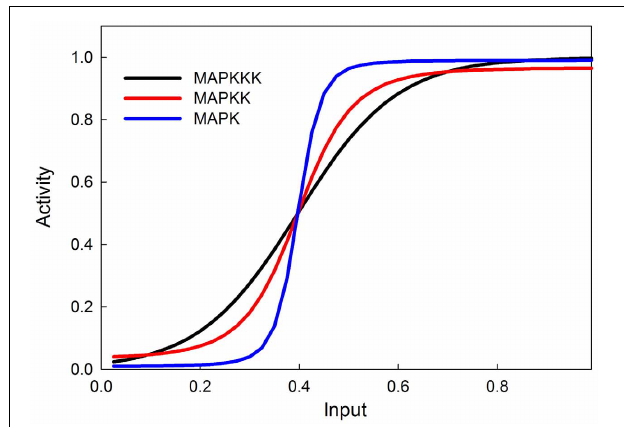
FIGURE 6 | Insulin dose response curves of various components of the insulin and MAPK signaling pathways replicating (Stagsted et al., 1993; Sedaghat et al., 2002; Danielsson et al., 2005). The GLUT4 transporters are the most sensitive to insulin signaling, and achieve their maximum response at relatively low levels of insulin stimulation